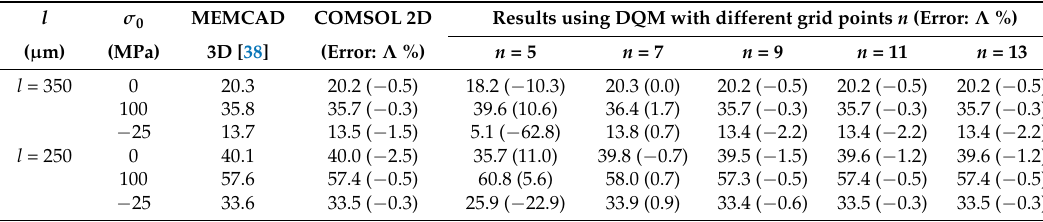
Table 4. Static pull-in voltage of microresonator with different beam lengths and residual stress (Unit: V).